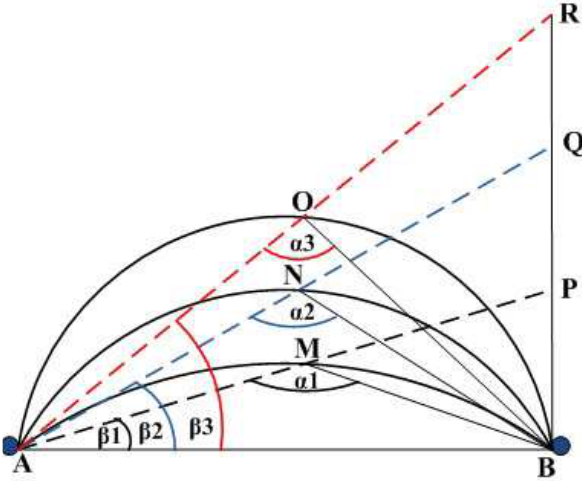
Figure 2. Relation between transmission path length and the angle α